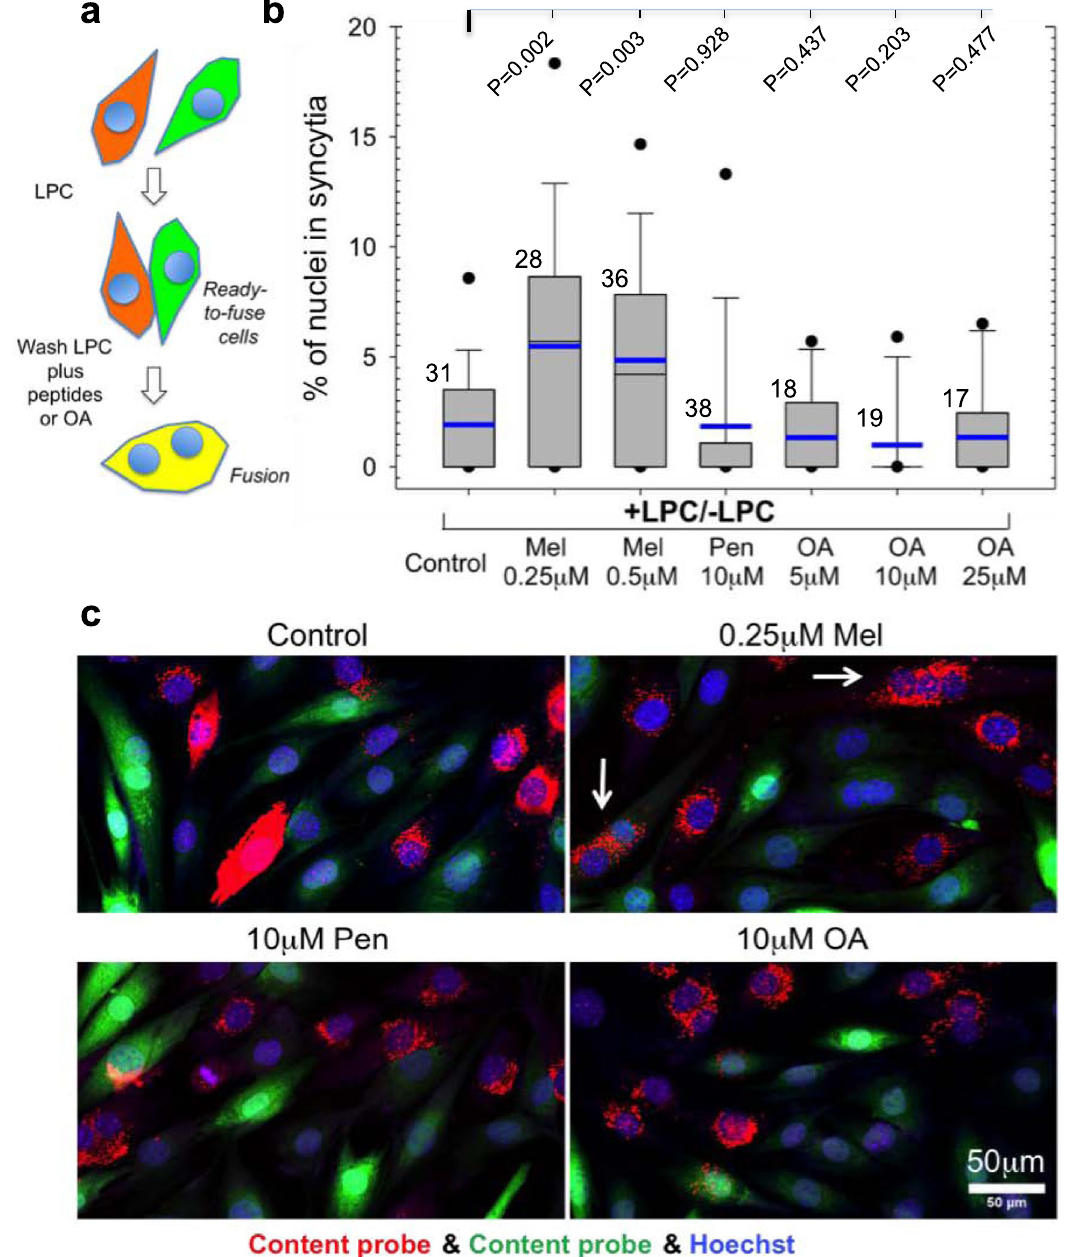
Fig. 9 A short-term application of melittin but neither penetratin nor oleic acid to Myomerger-de fi cient myoblasts synchronized by LPC promotes complete fusion of myoblasts. a Schematic showing synchronized myoblast fusion assay. b Differentiating Myomerger-de fi cient cells were accumulated upstream of hemifusion by the incubation in the presence of lysophosphatidylcholine (LPC). After 3 days in the differentiation medium (DM), LPC- supplemented DM was replaced with LPC-free DM supplemented or not with melittin (Mel) or penetratin (Pen) or oleic acid (OA). 60 min later we fi xed the cells and scored fusion as the ratio of nuclei in the cells with ≥ 2 nuclei to the total number of nuclei. N , the number of randomly selected fi elds of view examined for each condition over two independent cell preparations, is indicated to the left of the box associated with that data. Box-and-whisker plots show median (center line), mean (blue line), 25 – 75th percentiles (box), 10 – 90th percentiles (whiskers), and 5 – 95th percentiles (solid circles). P -values were calculated using a two-tailed unpaired t -test. c Representative images for the experiments in b taken for the control cells and for the cells treated